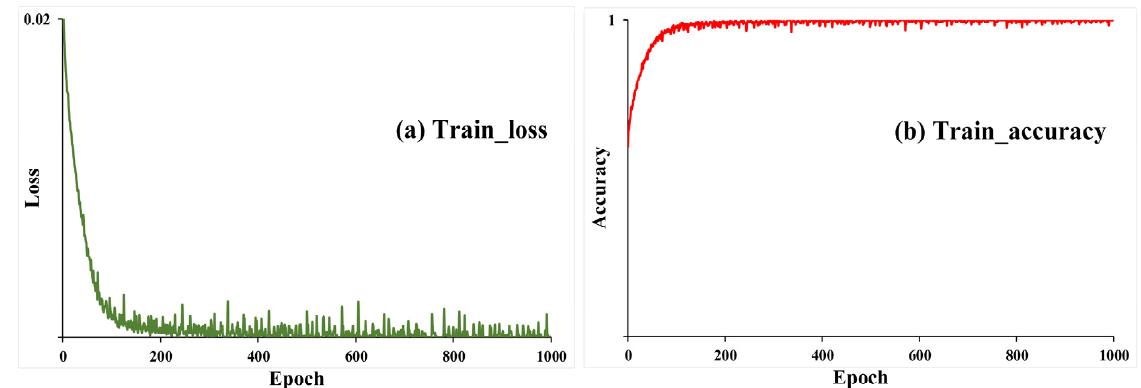
Figure 7. Loss curve and accuracy curve of the training set of MRCNN model.